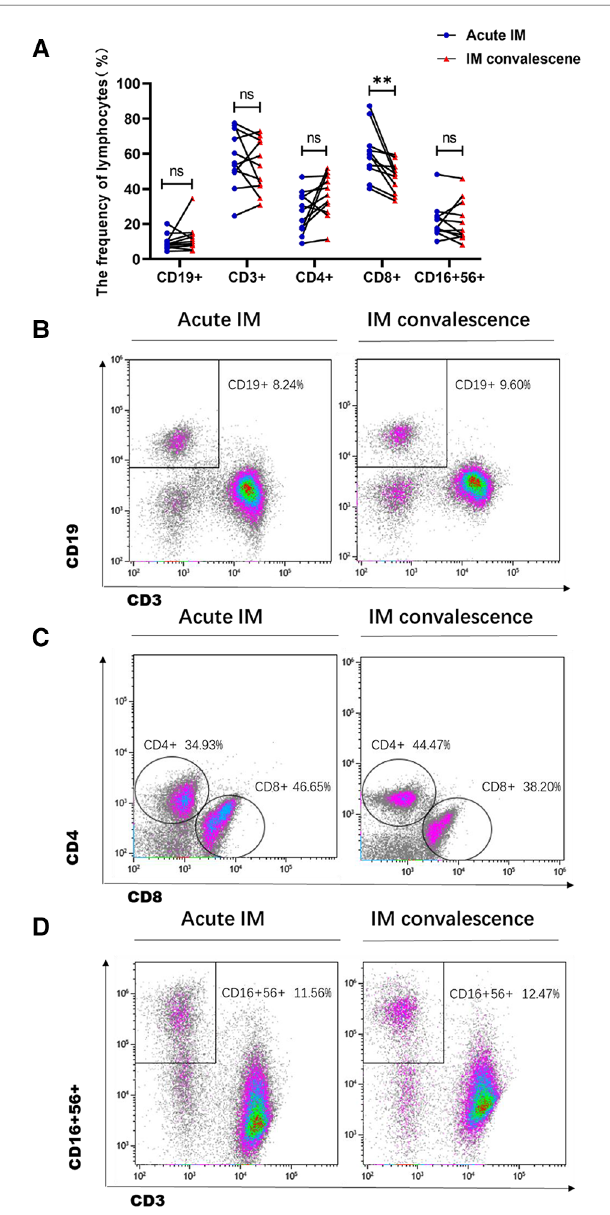
FIGURE 5 Analysis of frequencies of the lymphocyte subsets in IM patients after anti-viral therapy. ( A ) The frequency of lymphocyte subsets was analyzed between the acute phase and the early convalescent phase of IM disease. Representative dot plots showing the frequency of B cells ( B ), CD4 + and CD8 + T cells ( C ), and NK cells ( D ). ** P